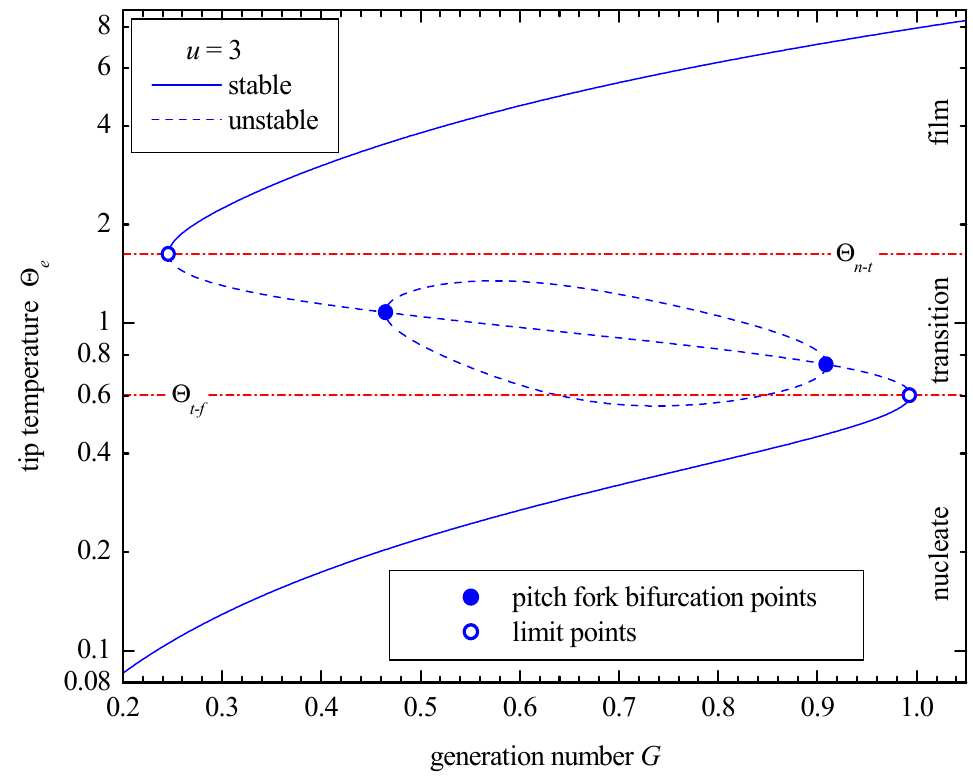
Figure 4. Solution structure for a wire with u = 3.